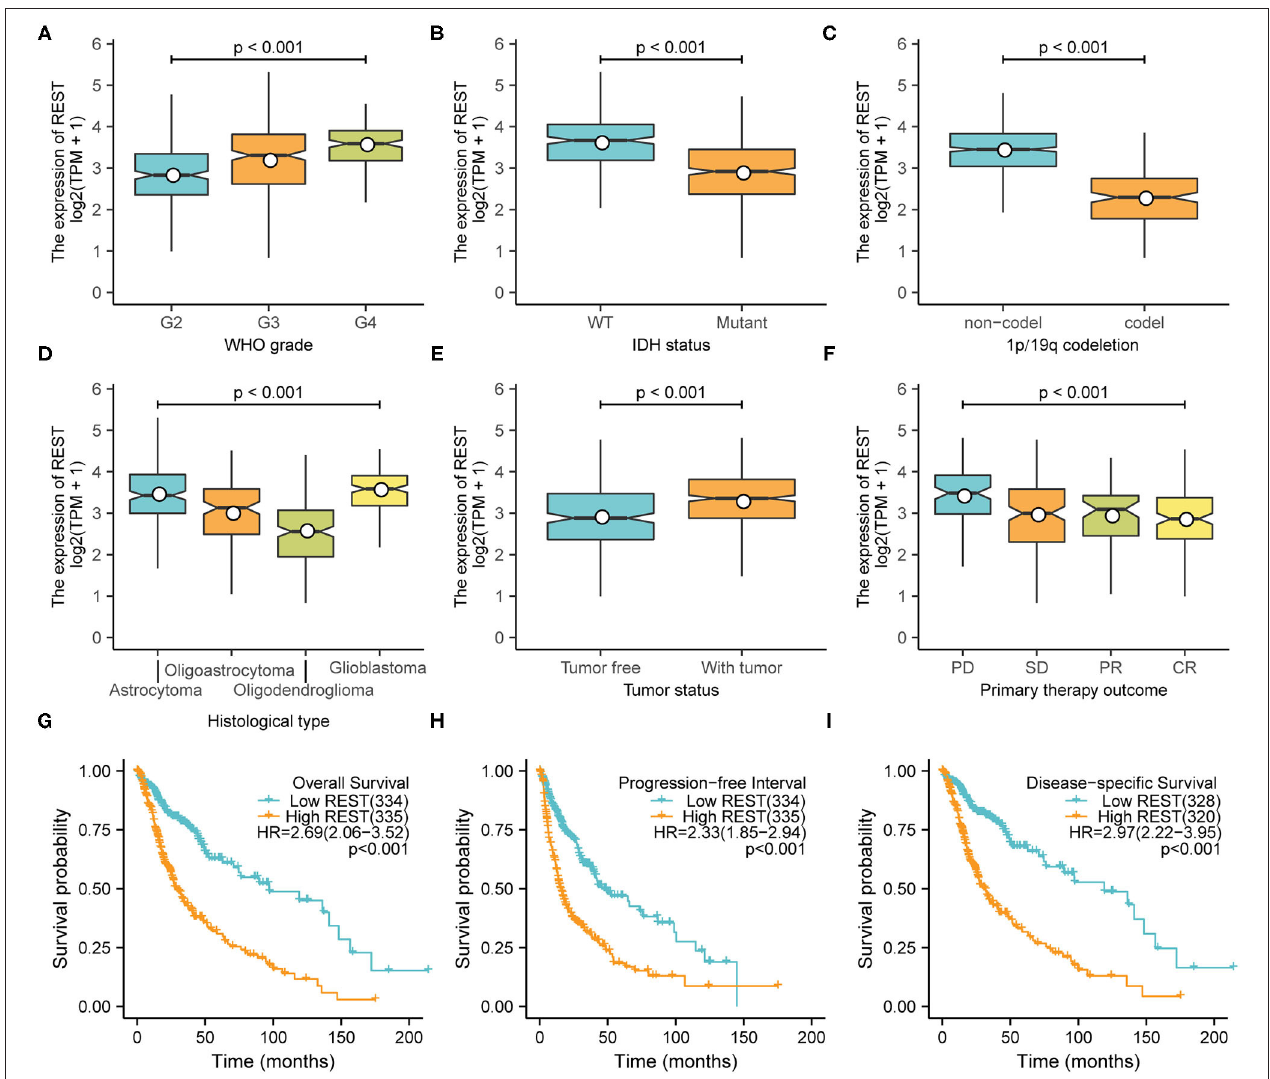
FIGURE 3 | High expression of REST was associated with worse characteristics. The correlation between REST expression and WHO stage (A) , IDH status (B) , 1p/19q codeletion (C) , histological type (D) , tumor status (E) , and primary treatment outcome (F) . Prognostic analysis of REST expression and overall survival (G) , progression-free interval (H) , and disease-specific survival (I) . Data were analyzed using Kruskal–Wallis test (A,D,F) , Wilcoxon signed-rank test (B,C,E) , and Kaplan–Meier analysis (G–I)